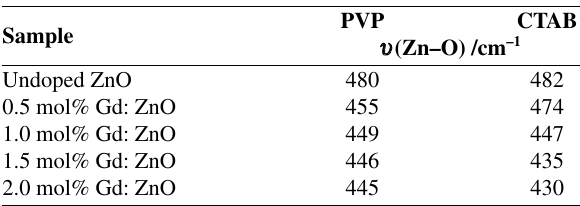
Table 1. IR frequency shift of Zn–O stretching frequency under the influence of Gddoping.